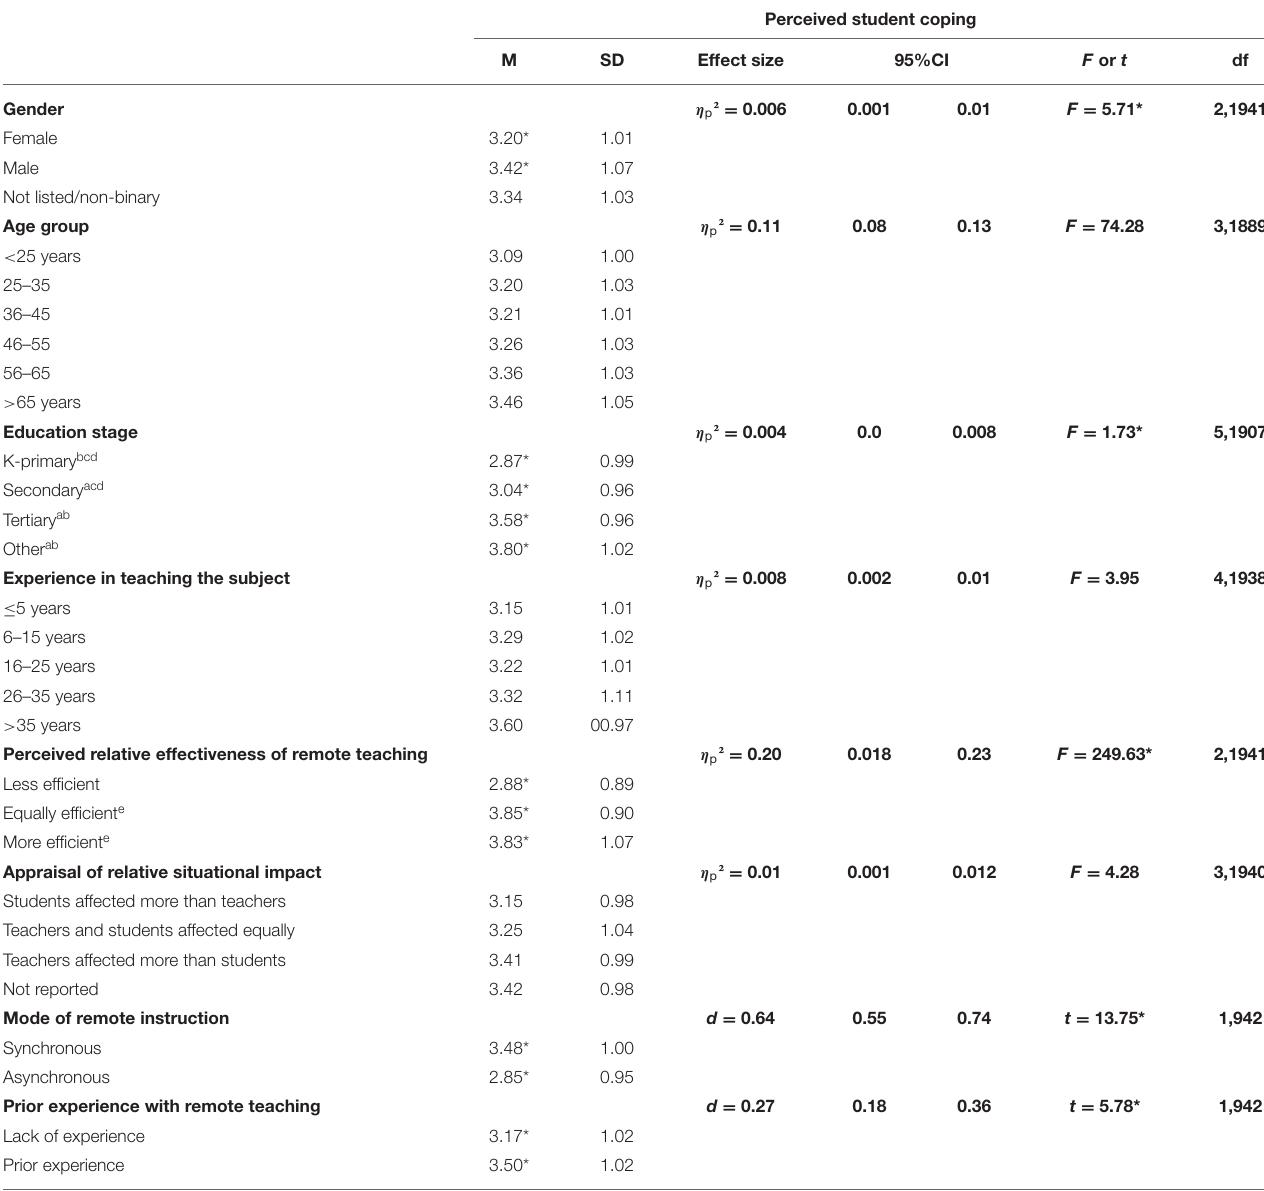
TABLE 2 | Significant differences in teachers’ perception of student coping with remote learning ( N = 1,944).